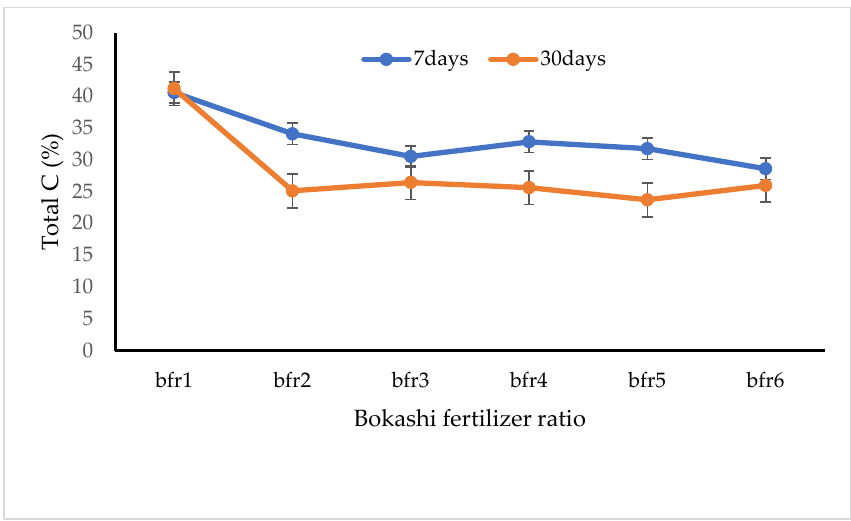
Figure 6 . Interaction effects between bokashi fertilizer ratios and time of bokashi maturation (days) on the total C (%). Bfr1 = (80% HBW:0% CD:20% PHC), bfr2 = (80% HBW:10% CD:10% PHC), bfr3 = (70% HBW:20% CD:10% PHC), bfr4 = (70% HBW:10% CD:20% PHC), bfr5 = (60% HBW:20% CD:20% PHC), bfr6 = (60% HBW:25% CD:15% PHC). HBW = horse bedding waste, CD = cow dung, PHC = paddy husk charcoal.